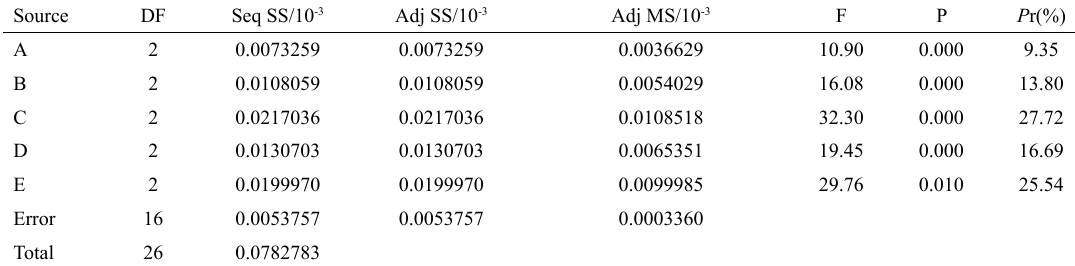
Table 8. ANOVA for co-efficient of friction of the hybrid composites